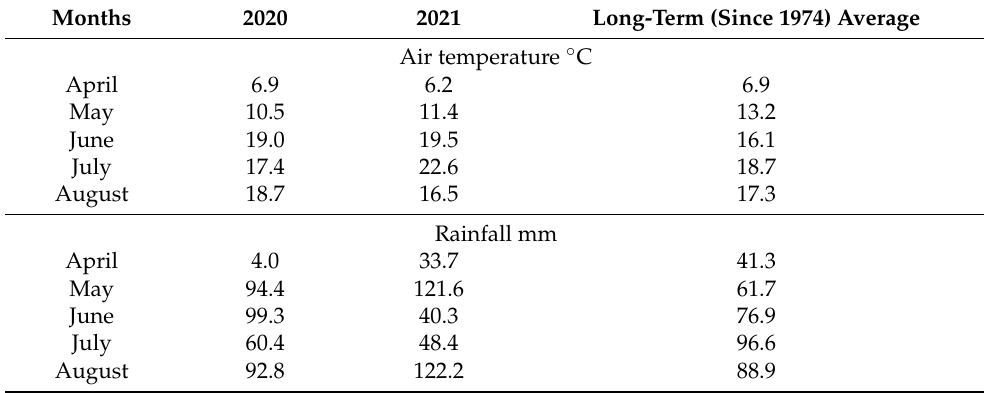
Table 2. Average air temperature and rainfall during vegetative seasons. Data from the Kaunas meteorological